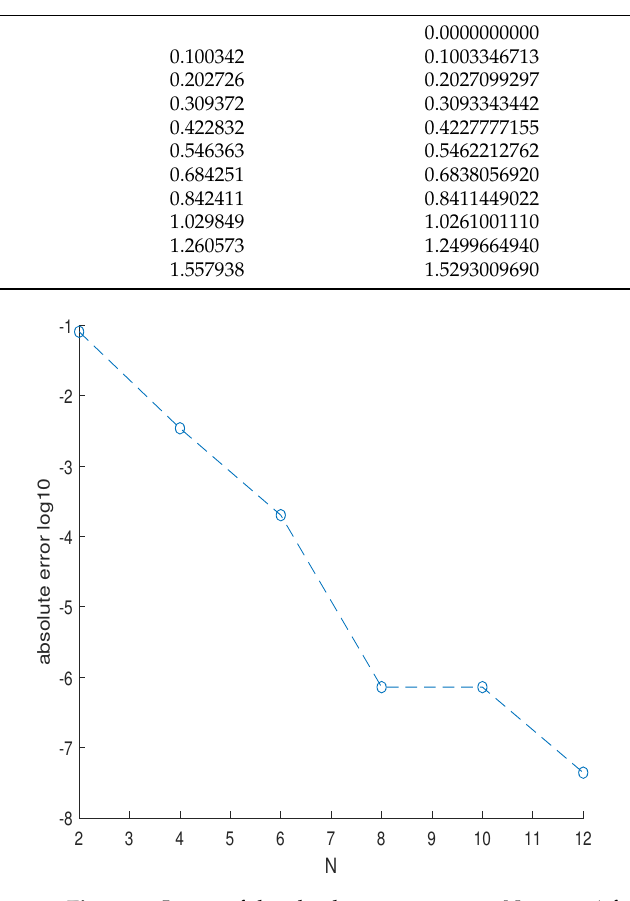
Figure 7. Log 10 of the absolute error versus N at ν = 1 for Example 4.